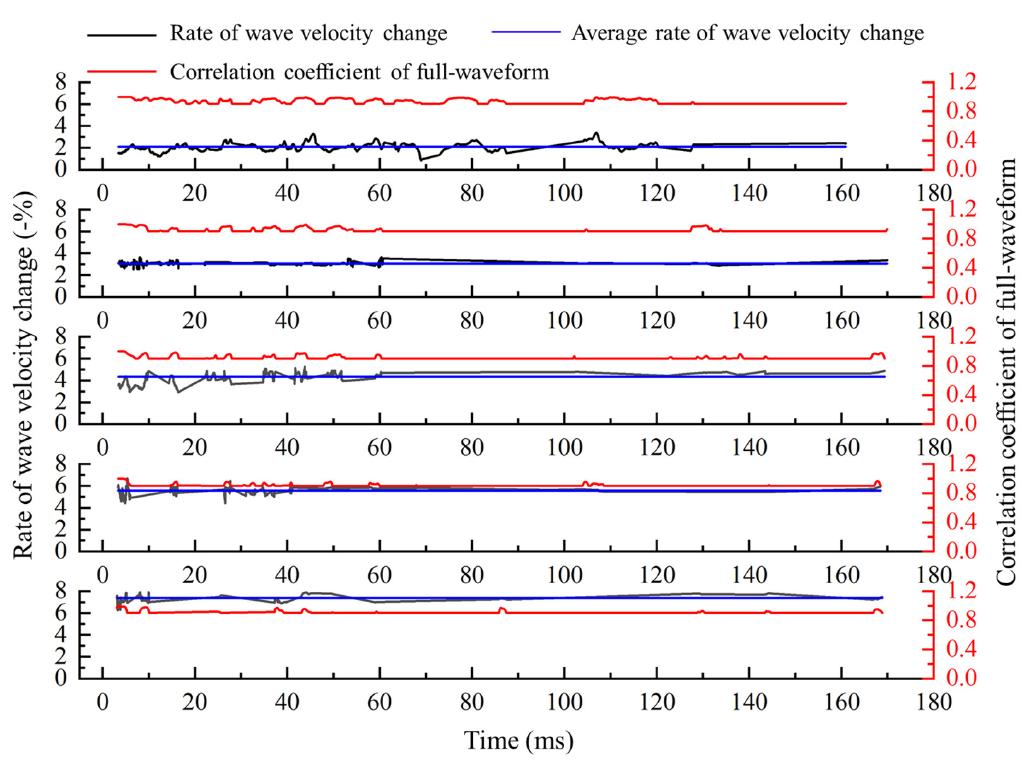
Figure 10. Rate of wave velocity change is calculated by the proposed method in this paper.